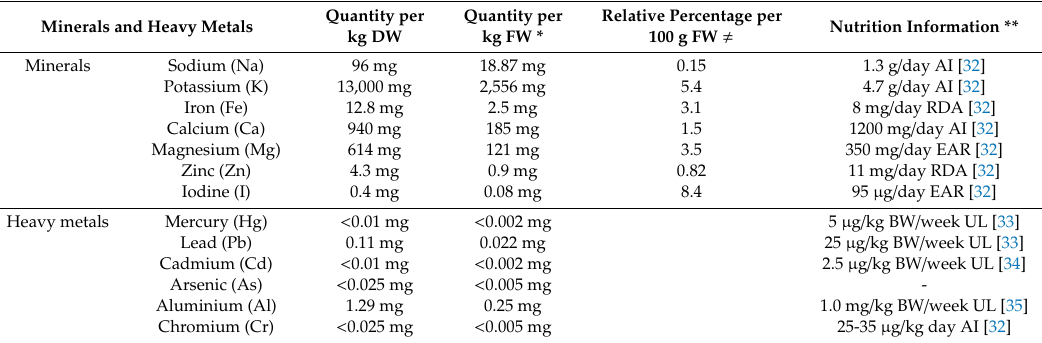
Table 3. Minerals and heavy metals in the powdered feijoa whole fruit sample.